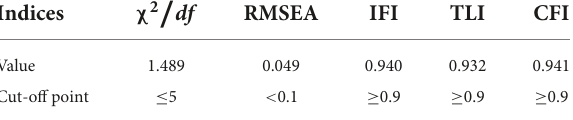
TABLE 5 Model fit